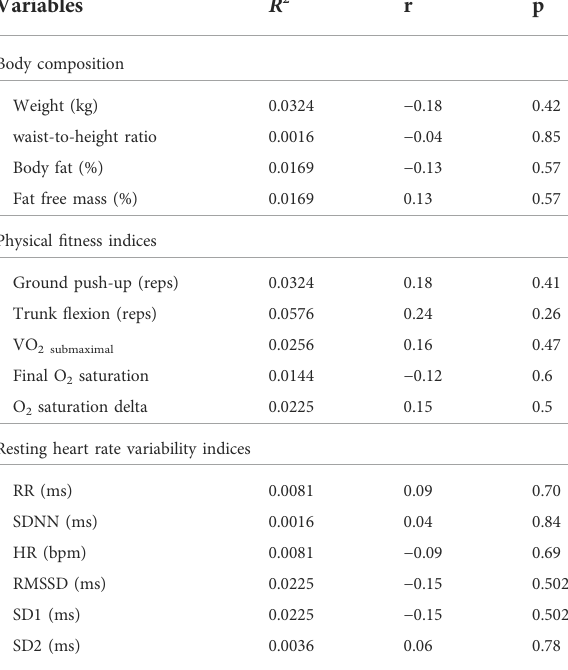
R-R(ms) — averageofR-Rintervalsinmilliseconds.SDNN(ms) — standarddeviationof RR, intervals in milliseconds.HR (bpm) — mean heart rate in beatsper minute.RMSSD (ms) square root of successive differences between R-R intervals in milliseconds. SD1 — The standard deviation of the Poincaré plot perpendicular to the identi fi